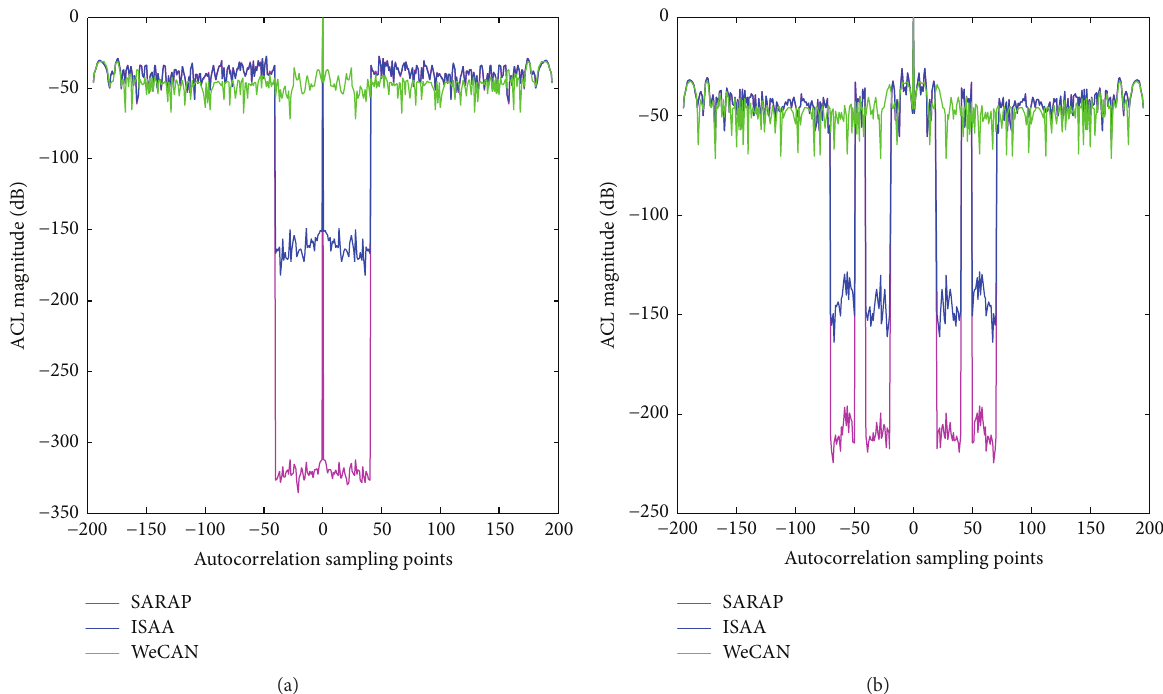
= [1 : 40] ; (b) illustrates the case 𝑄 1